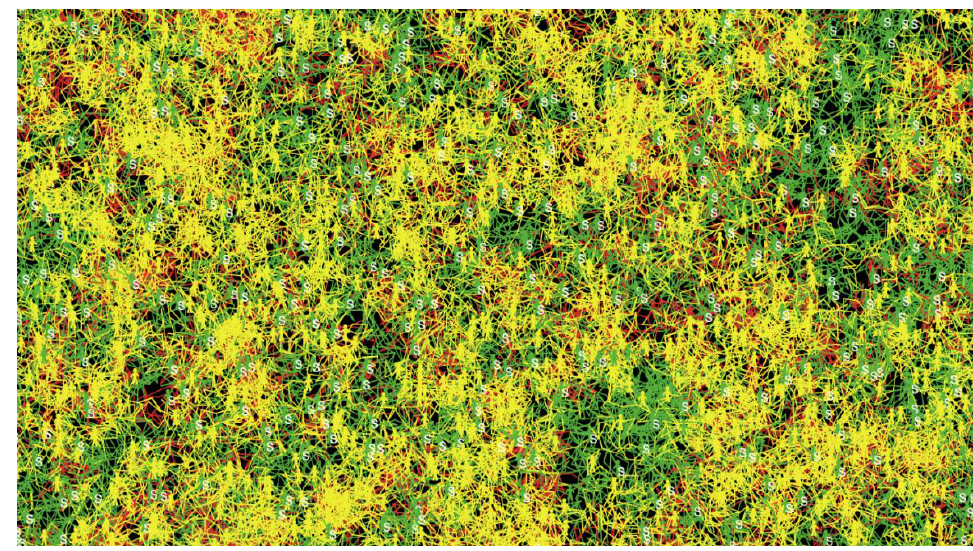
Figure 12. Movement patterns in the second experiment with 30% social distancing.